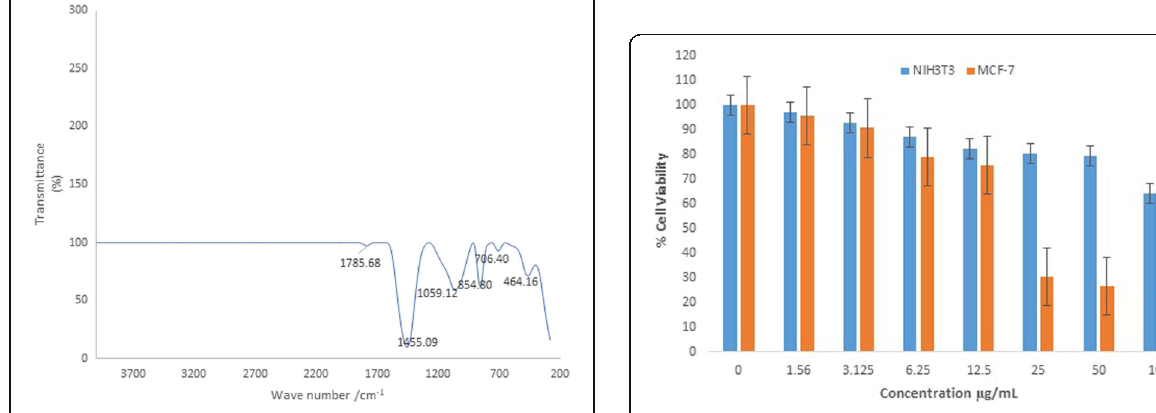
Fig. 6 Cytotoxicity assessment of the MCF-7 and NIH3T3 treated Au-CSCaCO 3 NPs cells using MTT assay giving percentage cell